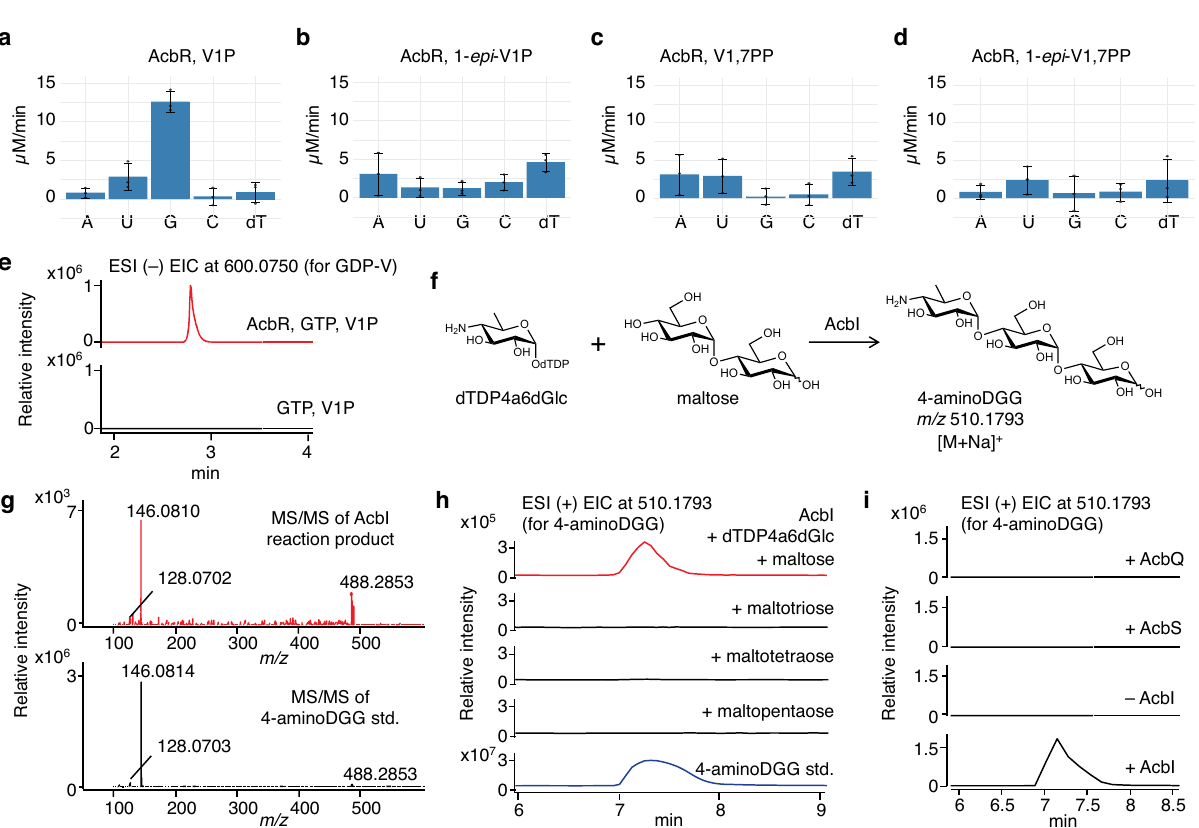
( 15 ) to NDP-V ( 16 ), as determined by an enzymatic coupling assay using inorganic pyrophosphatase (IPP), PNP and MESG (Fig. 3a, Supplementary Fig. 11) 35 . Among the fi ve nucleotidyl triphosphates tested, GTP was the preferred substrate, whereas UTP was also recognized as a substrate but with the rate of only about 25% of that for GTP (Fig. 3a, Supplementary Table 8). The formation of GDP-V was subsequently con fi rmed by LC-QTOF/MS (Fig. 3e). The steady-state kinetic studies of recombinant AcbR showed that the K m for V1P was 412 ± 83 μ M and the k cat was 14 ± 1 min -1 (Supplementary Fig. 12). The